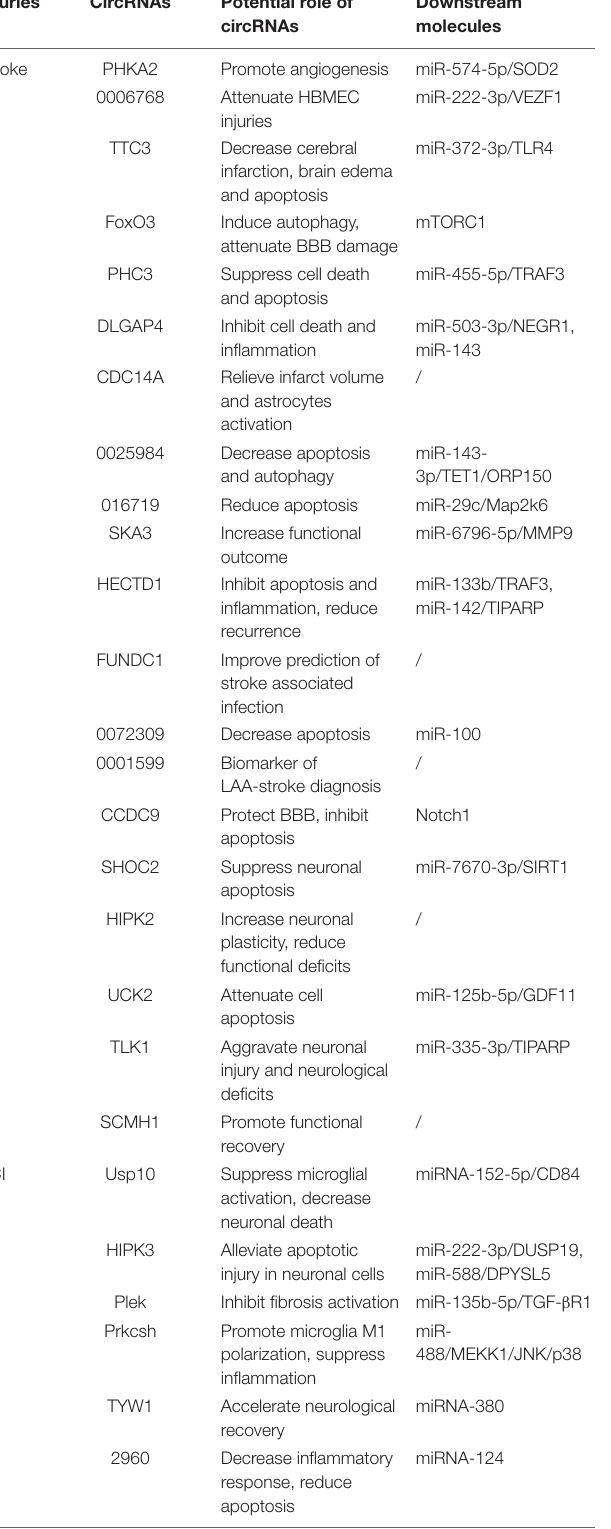
TABLE 1 | The acute central nervous system injuries with the potential role of circular RNAs.